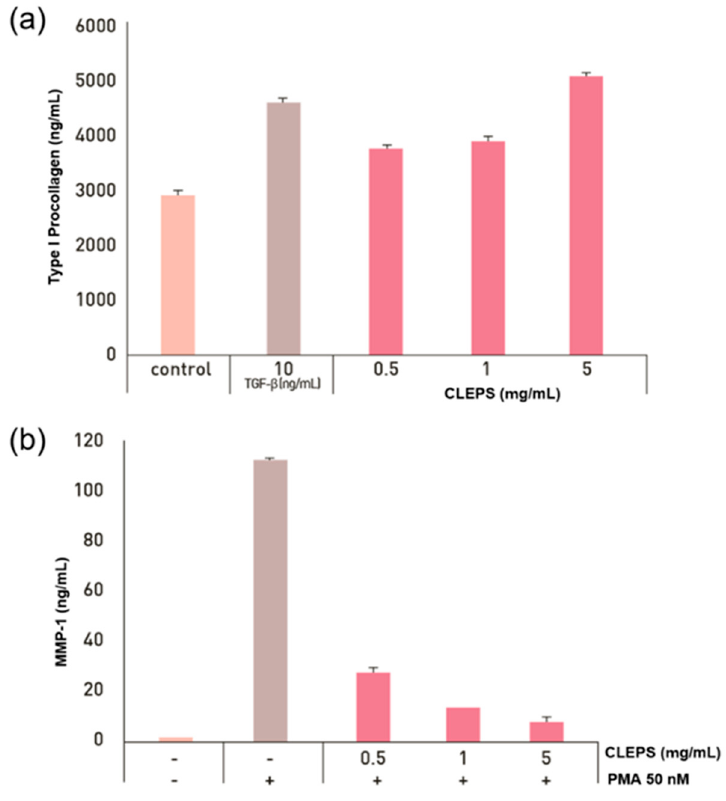
Figure 5. Effect of CLEPS on synthesis of collagen ( a ) ( p > 0.05 vs. control) and inhibition of collagenase ( b ) ( p > 0.05 vs. no PMA).